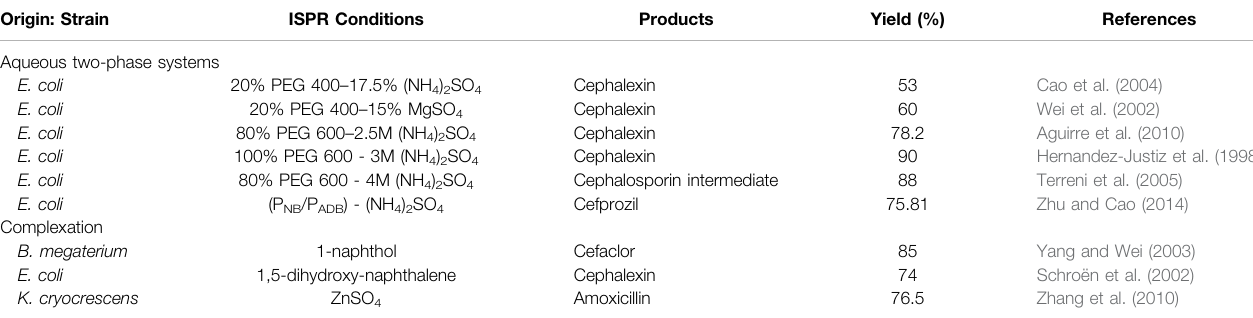
TABLE 4 | Application of ISPR in the synthesis of β -lactam antibiotics by PGA. Origin: